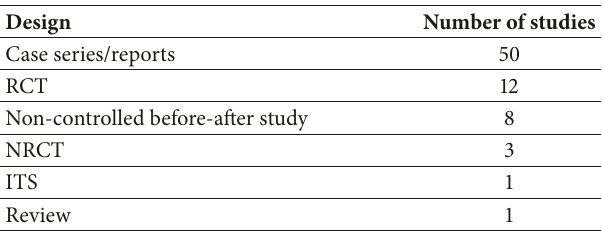
Table 10: Session frequency in included studies.